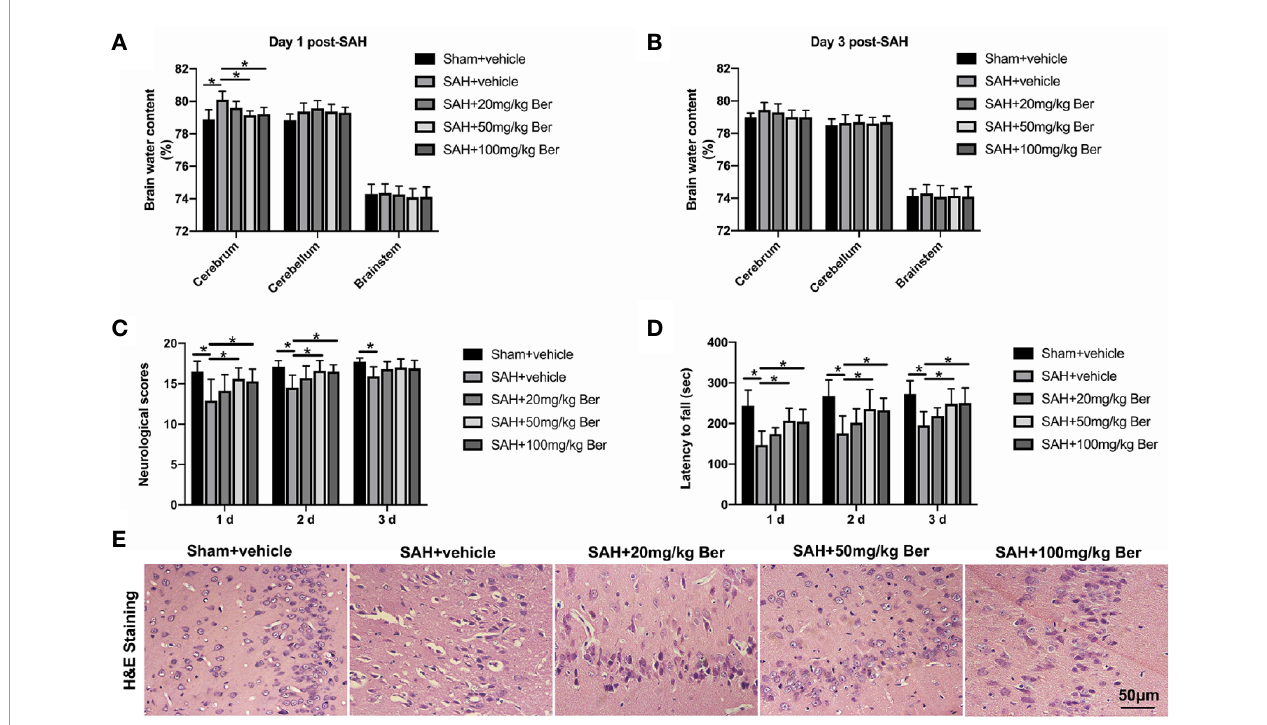
FIGURE 1 | Dose-response effects of berberine on subarachnoid hemorrhage (SAH) in rats. (A, B) Effects of three berberine doses on brain water content at 24 h (A) and 72 h (B) after SAH. n = 6 per group. (C, D) Effects of three berberine doses on neurologic scores (C) and rotarod performance (D) at 24 h, 48 h, and 72 h after SAH. n = 12 per group. (E) Representative photomicrographs of H&E staining at 72 h after SAH. n = 6 per group. Bars represent the mean ± SD. * P <